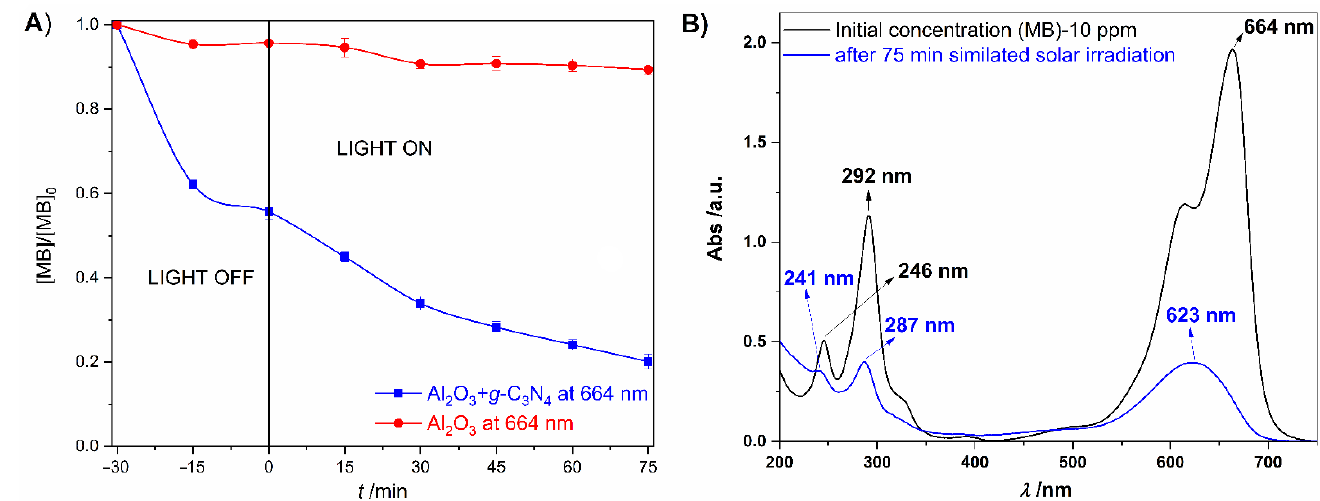
Figure 7. ( A ) Monitoring adsorption and degradation of alumina substrate (red) and immobilised g-C 3 N 4 on alumina substrate (blue), and ( B ) UV-vis absorbance spectra of initial concentration of MB dye and after 75 min photocatalysis.